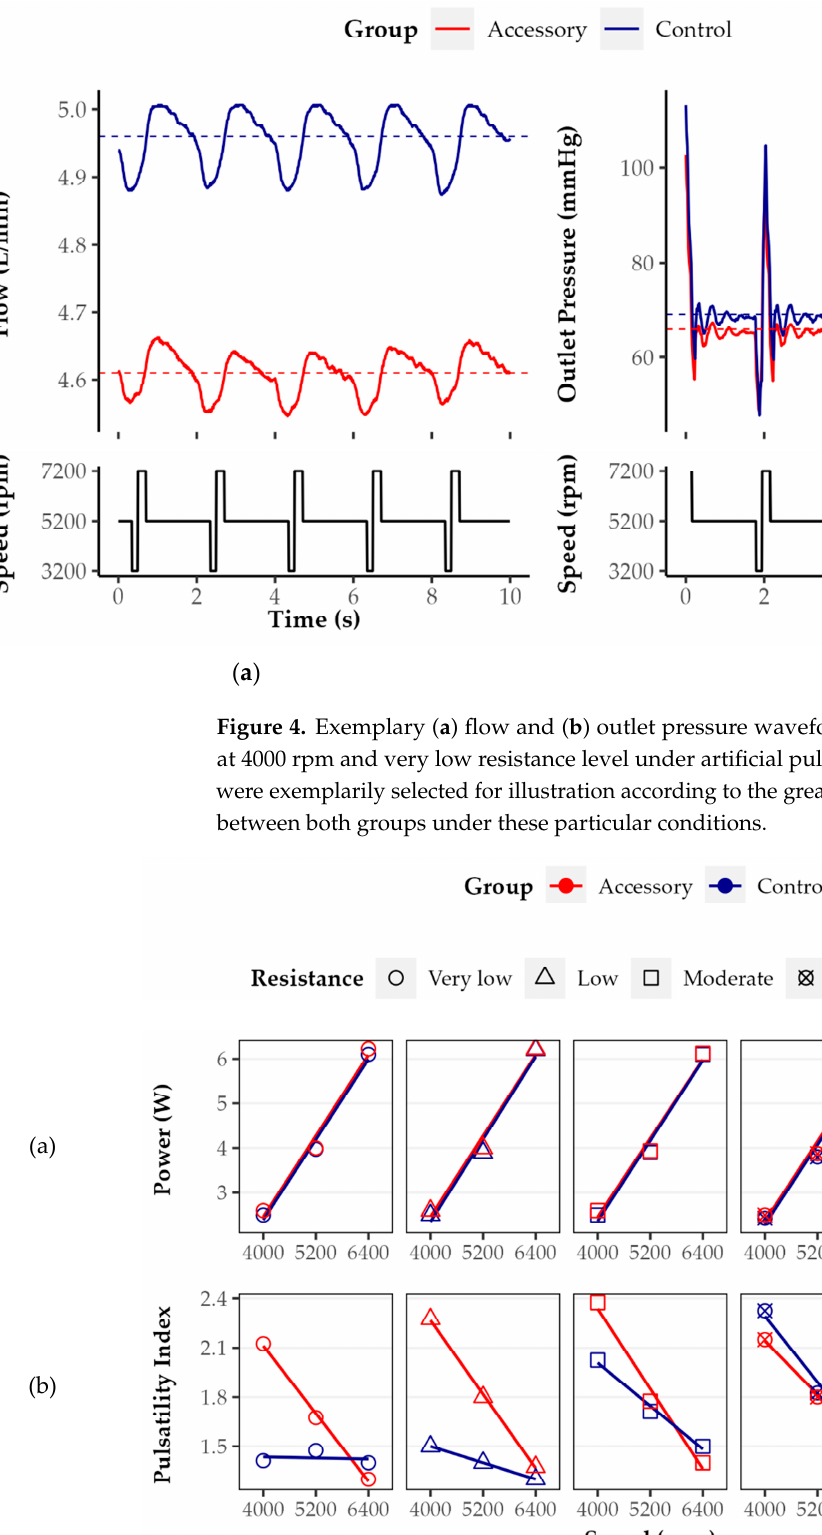
6 of 11 Figure 3. Pressure head versus fl ow (HQ) curves of HeartMate 3 with and without LVAD accessory at 3 rotational speeds (4000, 5200, and 6400 rpm). Each point in the diagram represents fl ow and pressure head at one resistance level (at same speed highest fl ow at lowest resistance). A change in pressure head in the Control group, for example, at 5200 rpm from 100 to 60 mmHg, led to nearly the same change in measured fl ow as in the Accessory group. 3.3. Flow and Outlet Pressure Wave Form Flow (Figure 4a) and outlet pressure waveform (Figure 4b) were comparable in both groups with respect to symmetry and frequency. Apparently, mean fl ow and mean outlet pressure was higher without the LVAD accessory. Furthermore, amplitudes of fl ow and outlet pressure were slightly decreased in the Accessory group. With and without the ac-